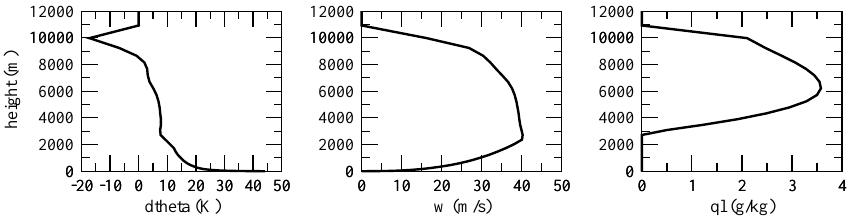
Fig. 4. Plume characteristics above the Chisholm fire: virtual potential temperature excess (K), vertical velocity (ms − 1 ) and cloud liquid water (gkg − 1 ).